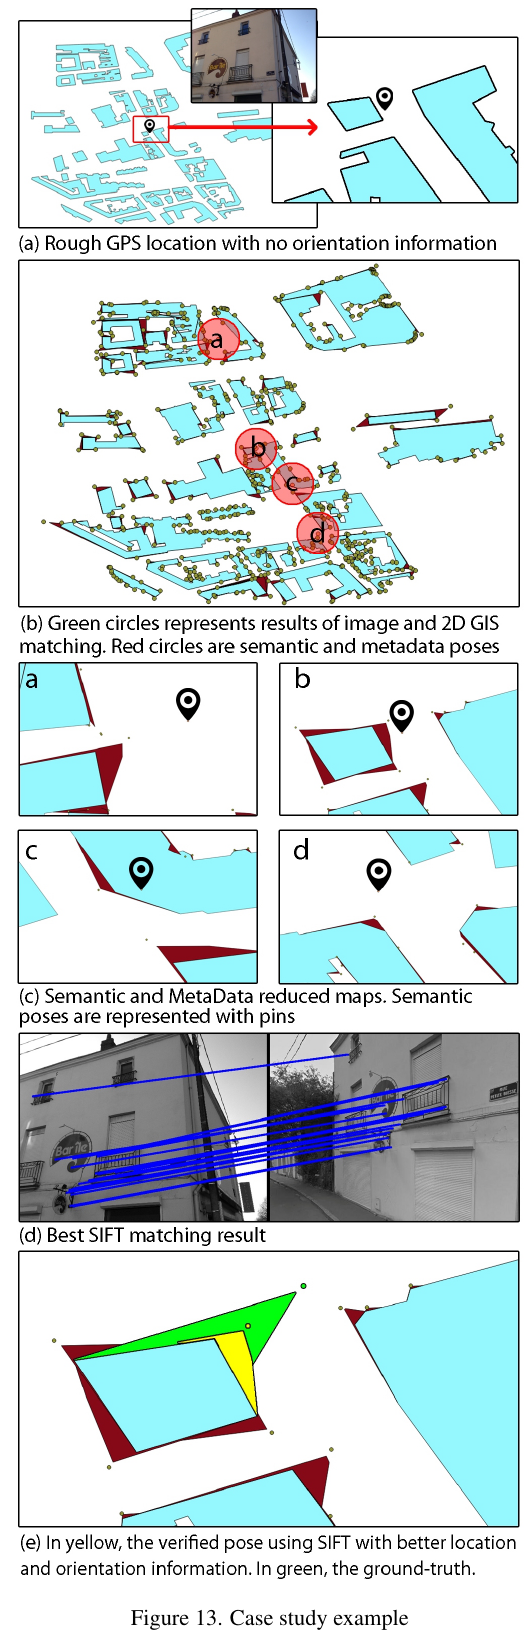
Figure 13. Case study